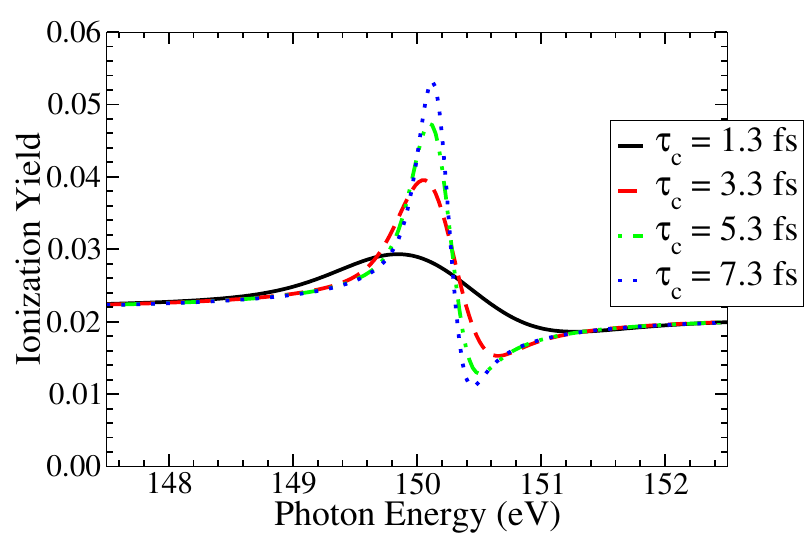
Figure 3. Effect of coherence time on the ionization yield is shown in this plot. As τ c increases, the ionization yield also increases, near resonance. The peak intensity is 10 13 W/cm 2 and the pulse duration τ p = 12.7 fs (525.02